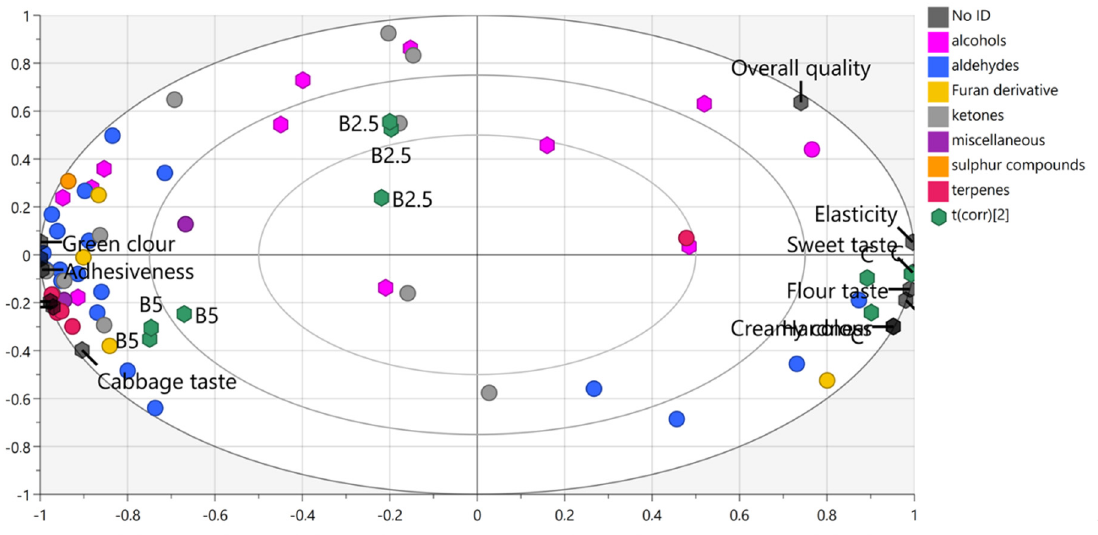
Figure 4. OPLS-DA score plot ( R 2 X = 0.866; R 2 Y = 0.991; Q 2 = 0.963) obtained for aroma-active VOCs and sensory attributes in experimental pasta. C: control pasta; B2.5: pasta fortified with 2.5% broccoli leaf powder; B5: pasta fortified with 5% broccoli leaf powder.